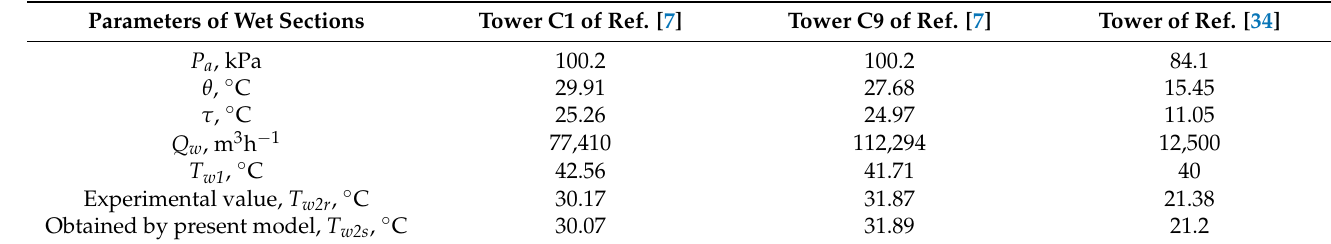
Table 2. Verifications for wet